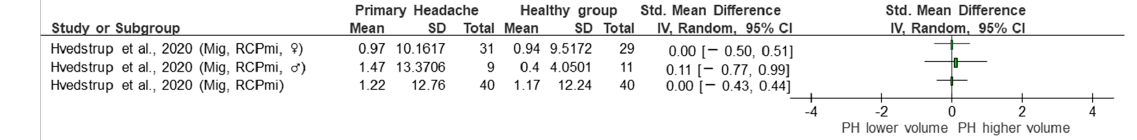
Figure 4. Forest plot of muscle volume quantification by magnetic resonance imaging (MRI). Graph shows the direction of change in muscle size in patients with primary headache towards a lower or higher MVQ. Mig: migraine, RCPmi: rectus capitis posterior minor, PH: primary headache, ♀ : fe- male, ♂ : male, lower volume: smaller area, higher volume: larger area. Authors: Hvedstrup et al. [23] .